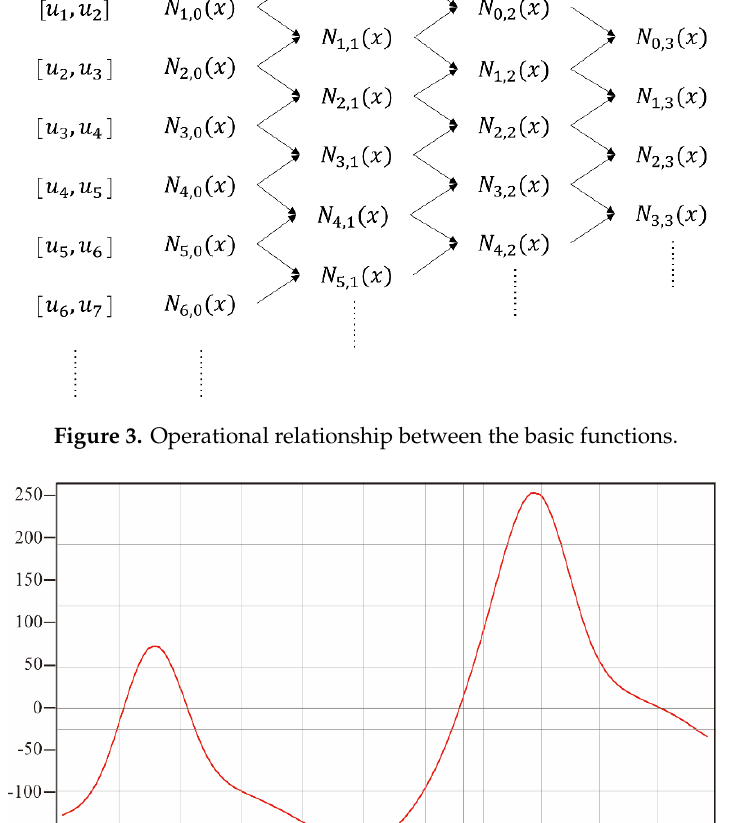
Figure 4. Smoothing the flow line by the cubic B-spline interpolation method.